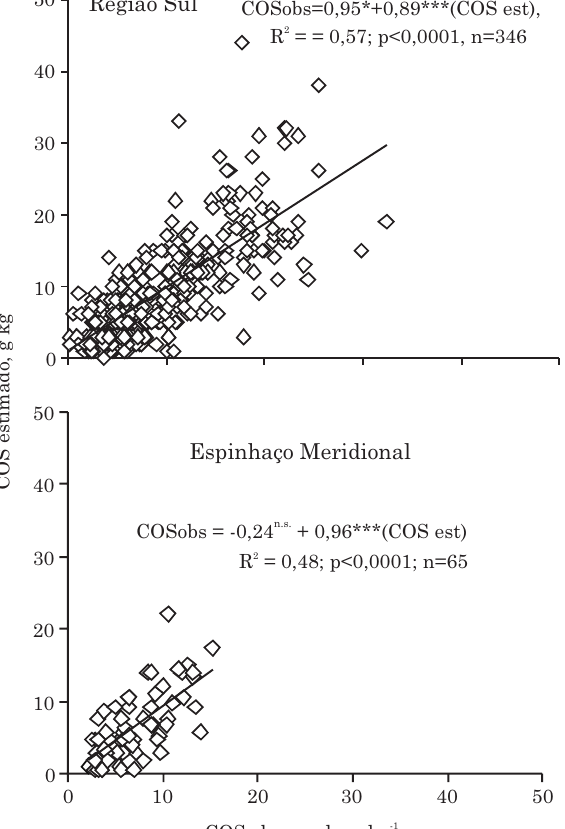
Figura 6. Desempenho dos modelos preditivos de perfis COS, para solos das regiões Sul e Serra do Espinhaço Meridional, MG. O nível de significância para os parâmetros intercepto e fator logarítmico é representado por *,** e ***, respectivamente, para p<0,05, p<0,01 e